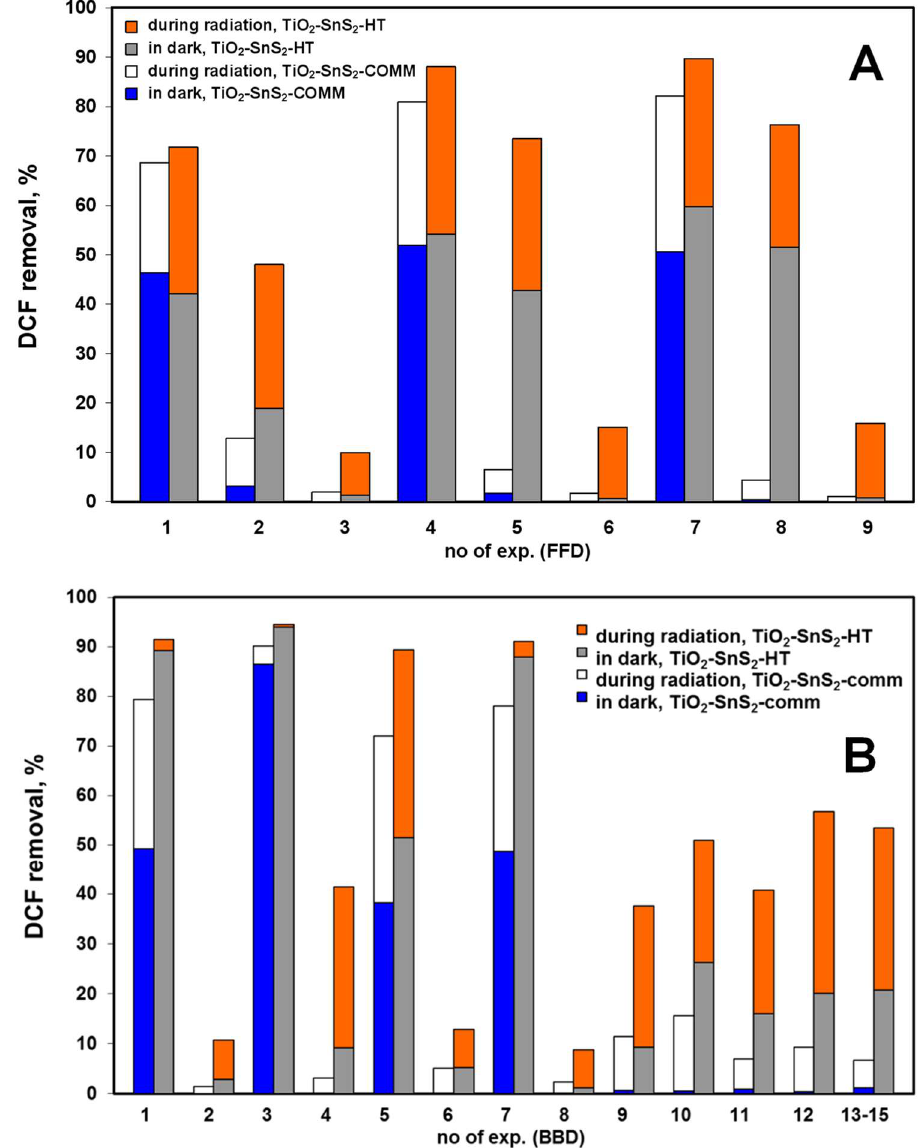
Figure 5. Comparison of DCF removal using TiO 2 -SnS 2 -COMM and TiO 2 -SnS 2 -HT without H 2 O 2 ( A ) and with H 2 O 2 addition ( B ) under solar radiation at conditions set by FFD (Tables 1, S1 and S3, Supplementary Material) and BBD (Tables 1, S2 and S4, Supplementary Material), respectively.